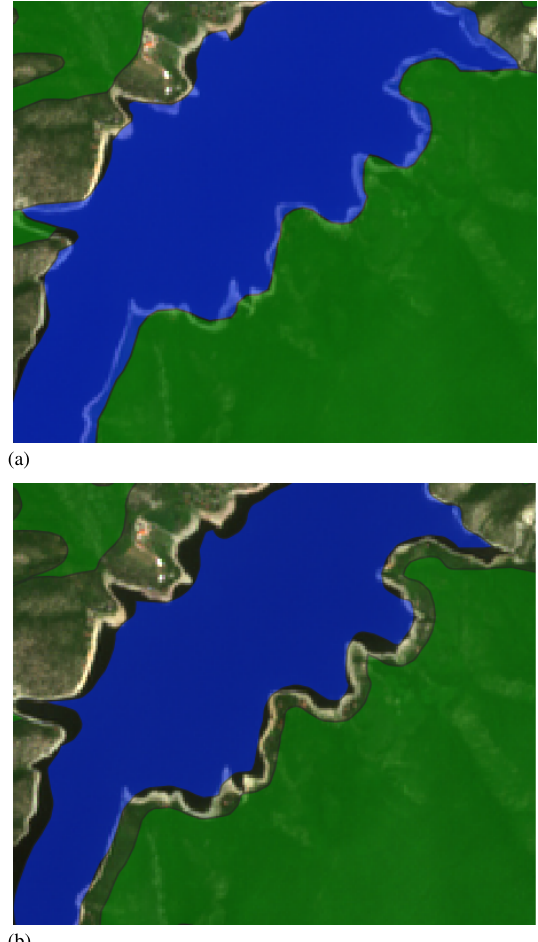
Figure 5. Editing of CORINE data: a) original polygons b) application of inner buffer.